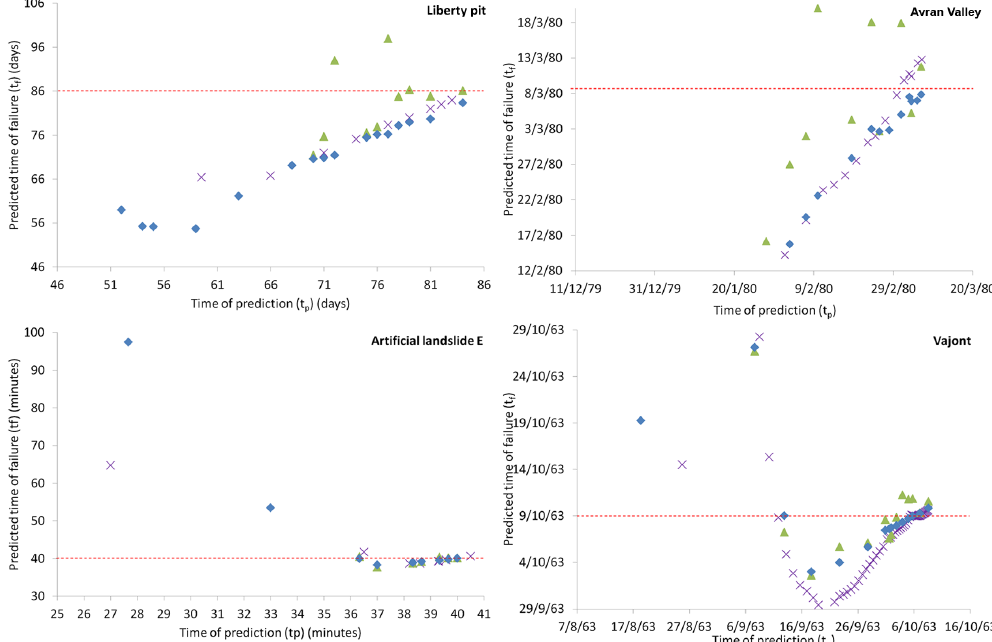
Figure 2. Prediction plots of four different case studies. The dashed line indicates T f . The crosses represent forecasts performed with the S method, the triangles with the F method and the diamonds with the M method. Note that F forecasts for Avran Valley landslide include other less accurate values not shown in the graph since they are out of